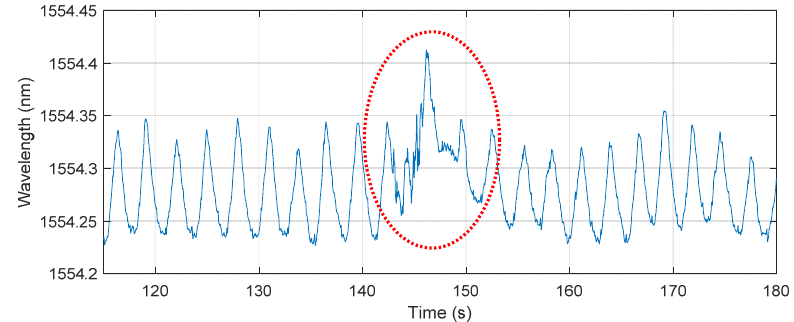
Figure 7. Distortion on the breathing pattern due to a fetal movement. Figure 8 shows exemplary distortions induced by the fetus at 438 s over all eight sensors during a 30 s measurement window on a pregnant volunteer. During the fetal movement, the breathing signal was interrupted by a distortion in the wavelength causing a sharp peak influenced by the movement. Corresponding ICA data with the breathing signals removed is shown in Figure 9. A clear signal at 437–438 s can be observed indicating a fetus movement. The time when the fetus movement was detected correlates well with mother’s perception, which is indicated by the right y axis.